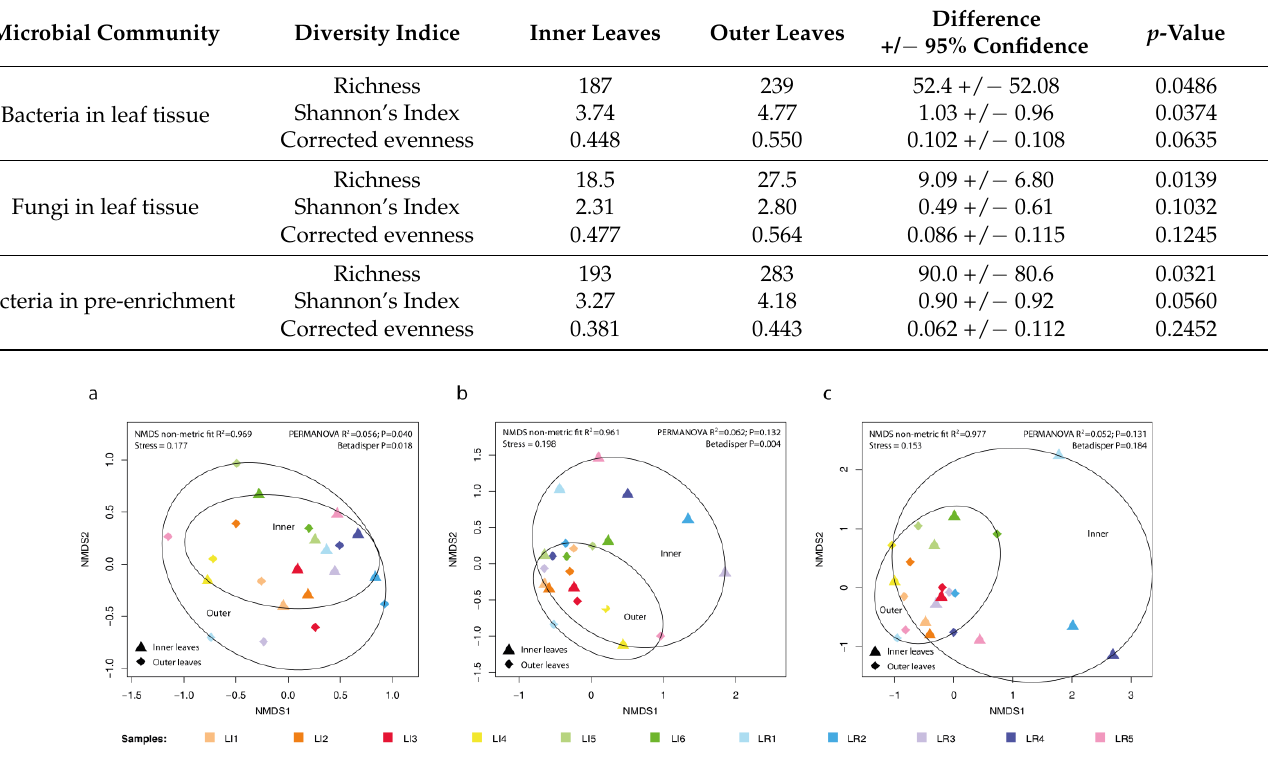
Figure 8. NMDS scatterplots of microbial communities in samples of inner and outer lettuce leaves. ( a ) Bacterial community in fresh tissue samples; ( b ) fungal community in fresh tissue samples; ( c ) Bacterial community in sample pre incubated in buffered peptone water.